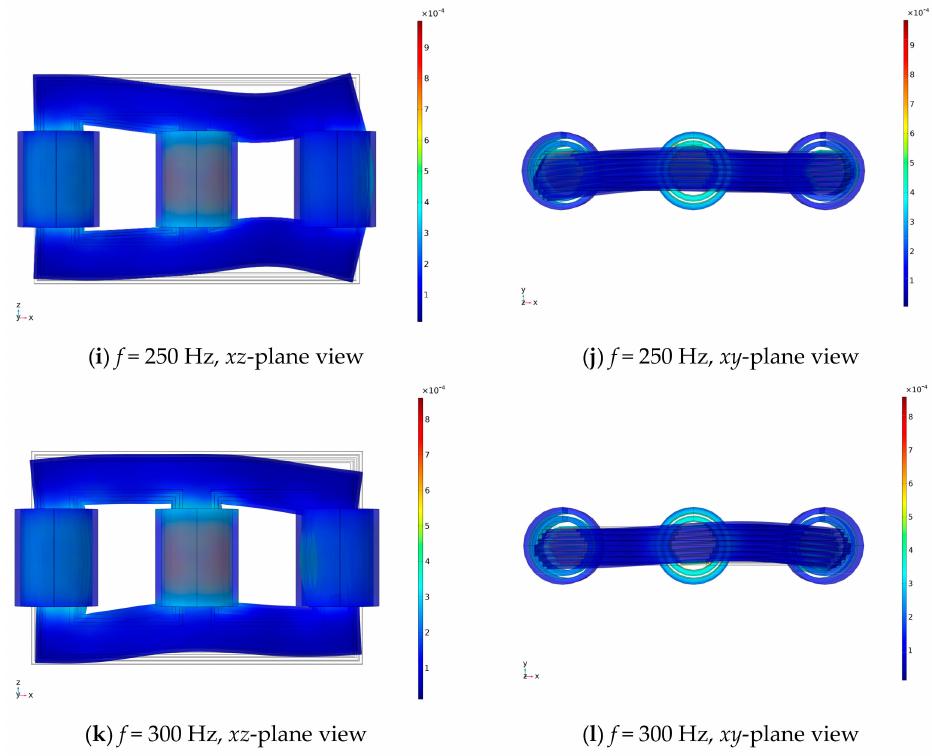
Figure 9. Vibration displacement with varying